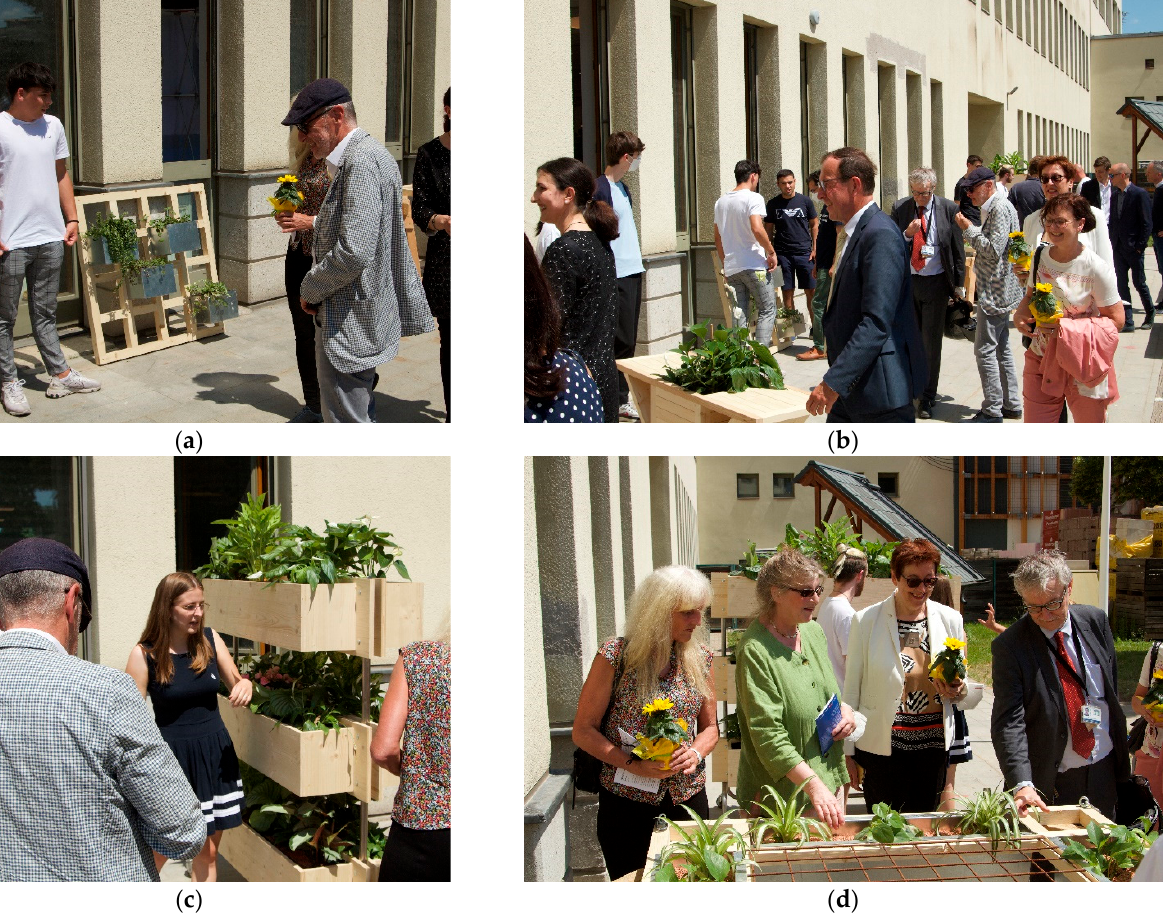
Figure 3. Presentation of the prototypes of the indoor greening systems at a public event in June 2021 at the Camillo Sitte Bautechnikum in Vienna: ( a ) modular wall greening system; ( b ) plantable seating furniture “Green Domino”; ( c ) plantable mobile partition wall; ( d ) plantable hanging system “Green Cloud”.